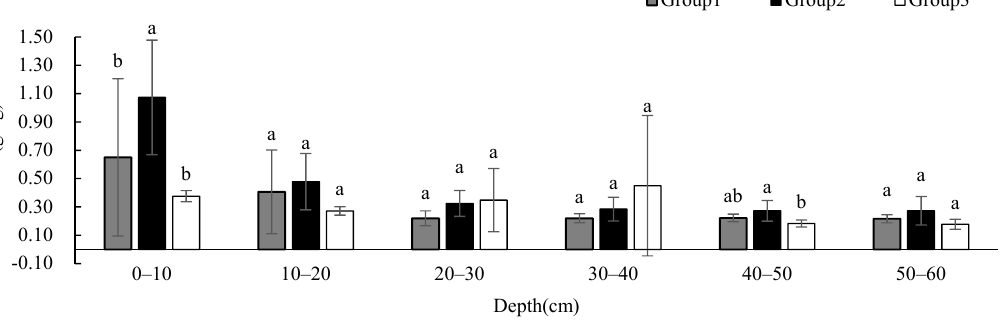
Figure 11. One-way ANOVA results of STN under different vegetation cover types at different depths ( p < 0.05; a > b).